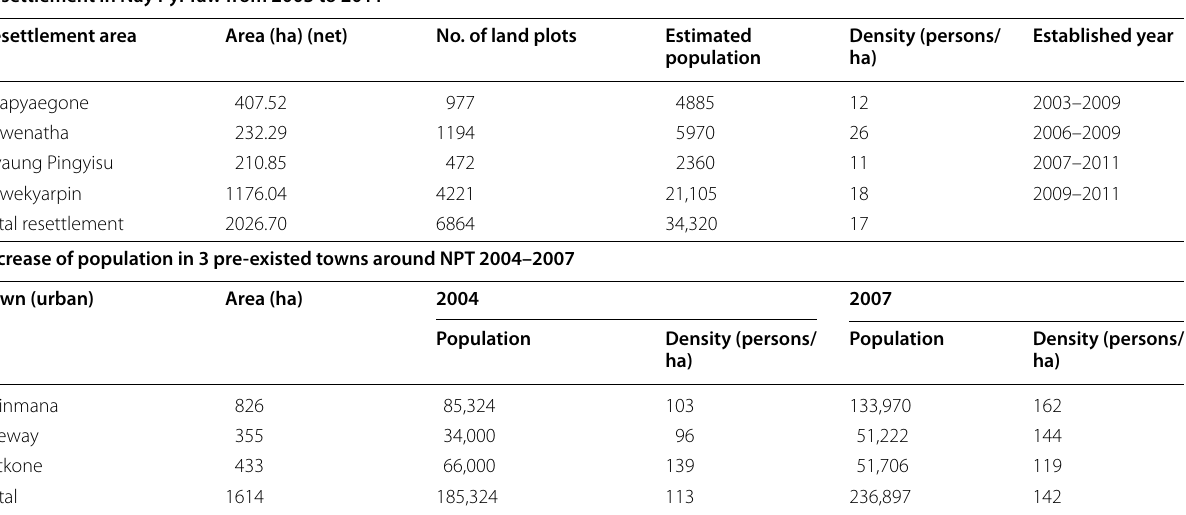
Table 3 Population changes in Nay Pyi Taw and surrounding area. Source: Department of Human Settlement and Housing Development (DHSHD), 2011 Resettlement in Nay Pyi Taw from 2003 to